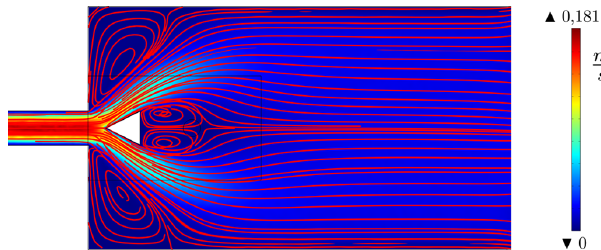
Figure 8. Simulated fluid flow past the triangular bluff body for wa- ter with a flow rate of 0.07mLs − 1 , with colours indicating velocity magnitude and streamlines depicted in red.